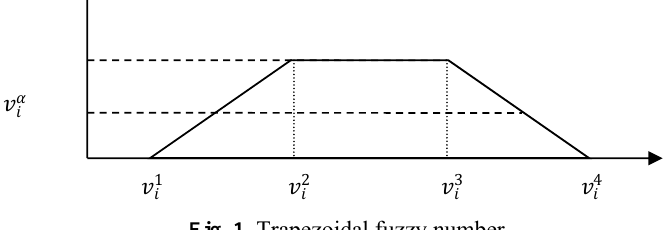
Fig. 1. Trapezoidal fuzzy